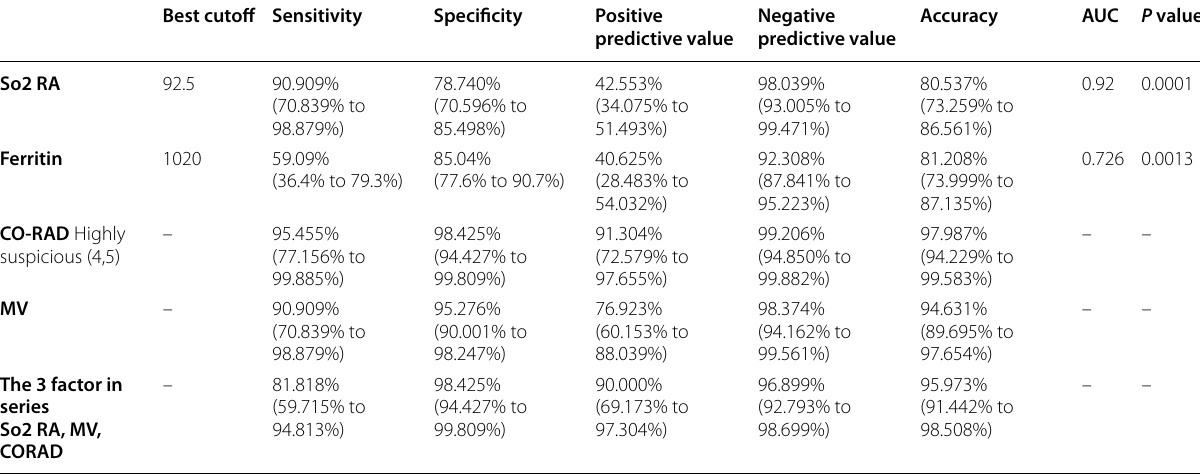
Table 3 Diagnostic test accuracy for prediction of mortality Best cutoff